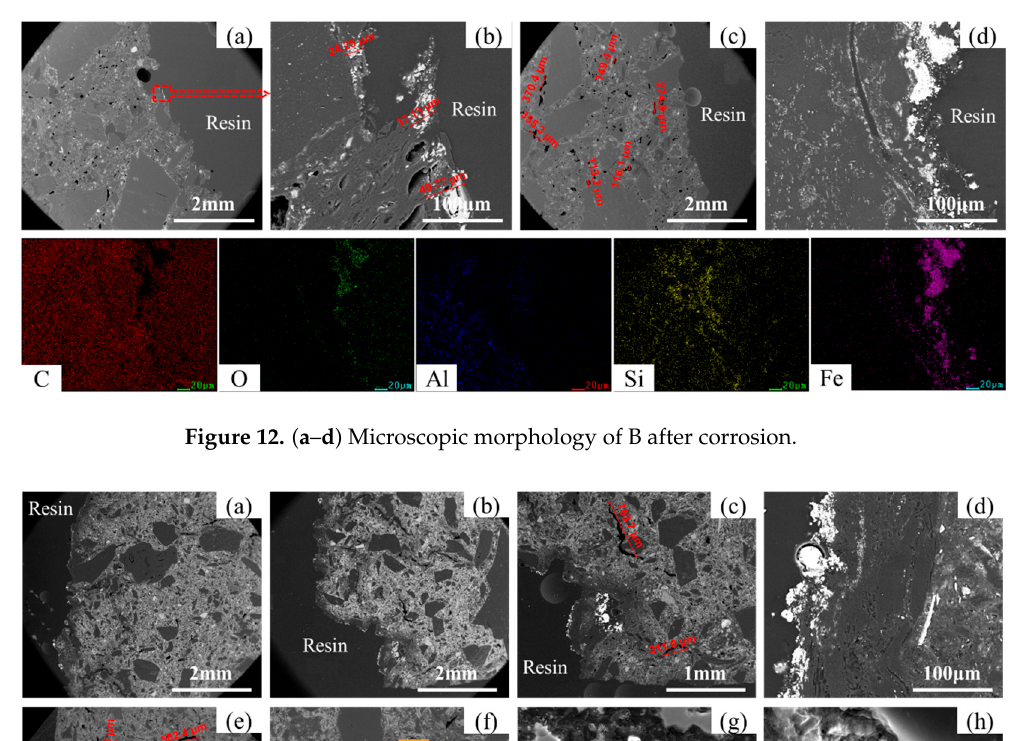
Figure 12. ( a – d ) Microscopic morphology of B after corrosion.